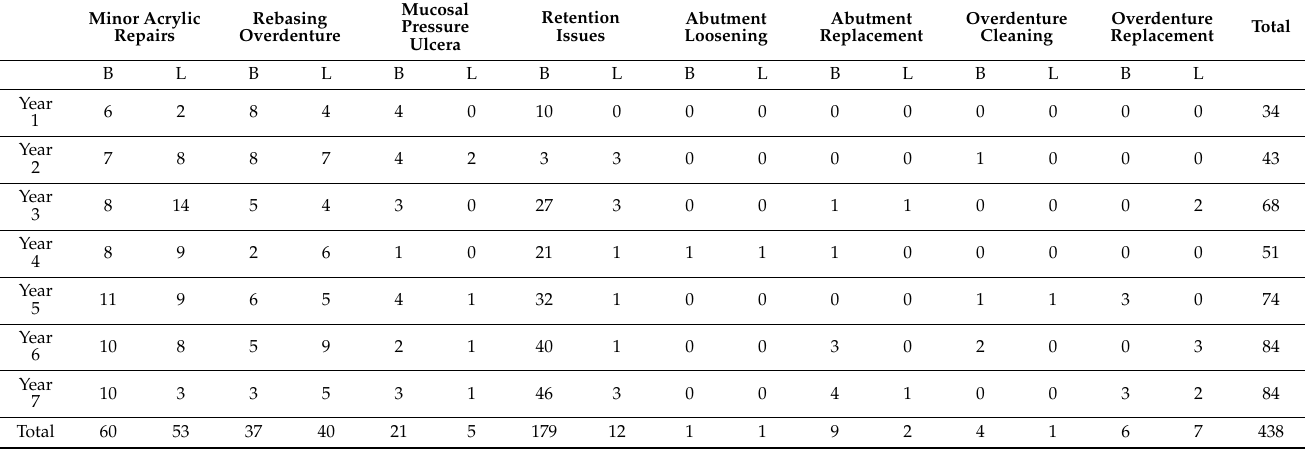
Table 2. Detailed specification of all maintenance issues and repairs between the different treatment groups (B = Ball, L = Locator) up to 7 year after implant